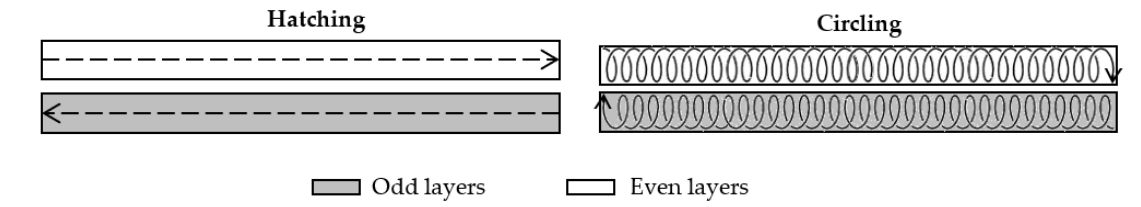
Figure 2. Deposition strategies of the study.